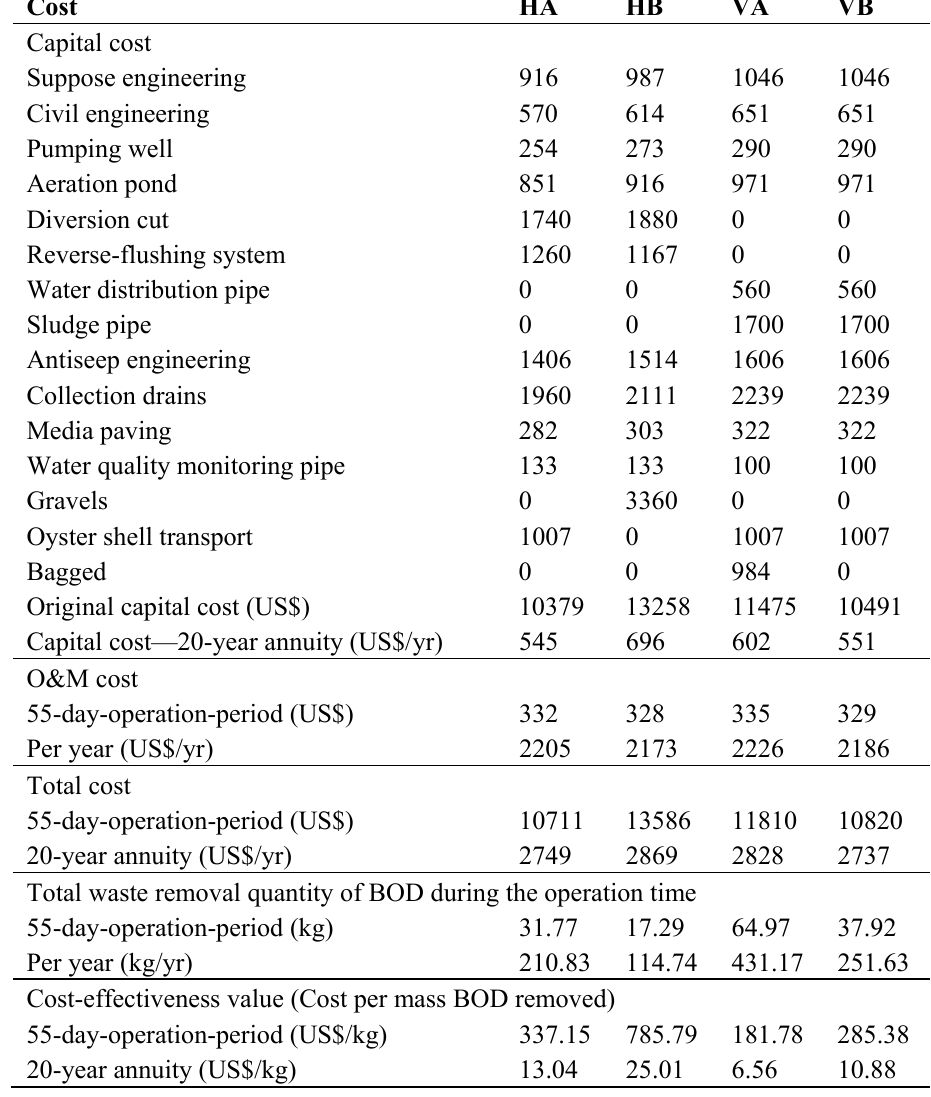
Table 6. Results of cost-effectiveness analysis of the four study SSF